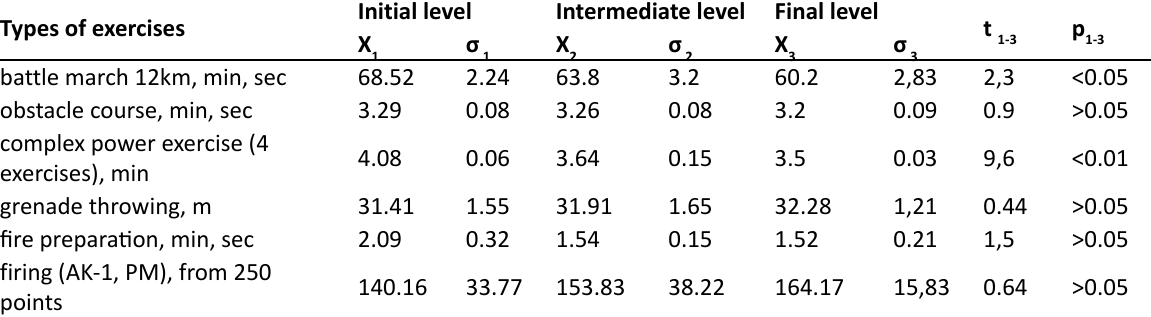
Fig. 1. Results of expert estimation of weighting coefficients of types of training Table 2. Results of training of cadets for examination on the right to wear the beret with honors Types of